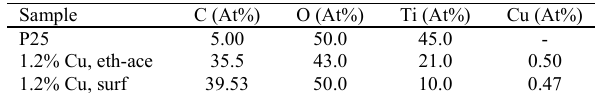
Table 2: Chemical composition of the prepared samples (At%: atomic%). Table 2. Chemical composition of the prepared samples (At%: